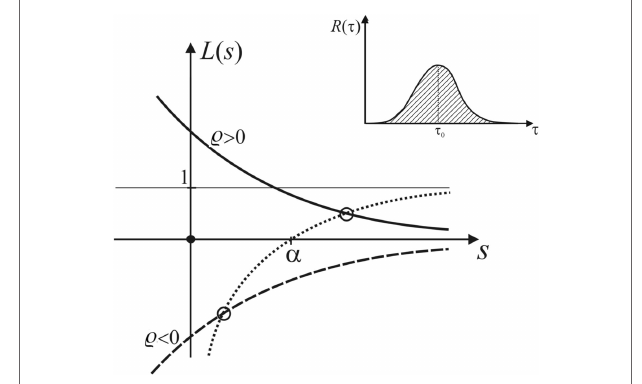
FIGURE 9 | Plot of L ( s ), showing that the latter always intersects the function 1 (cid:0) (cid:11) s in the domain of positive s if (cid:11) is positive